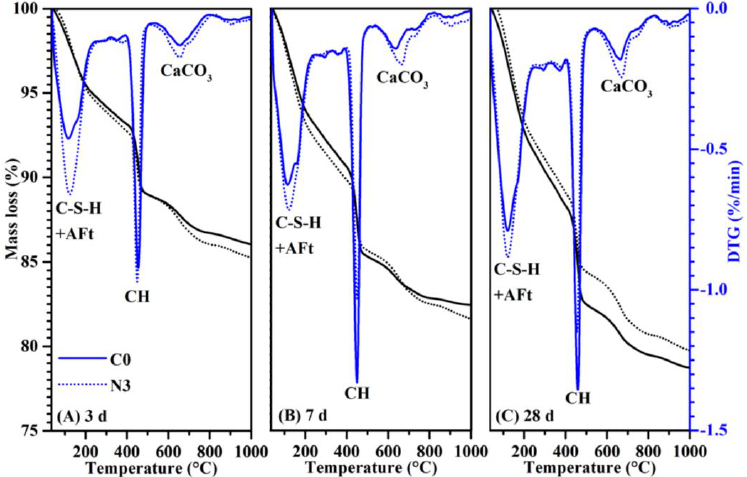
Figure 16. TG-DTG curves of different cement pastes at ( A ) 3 days, ( B ) 7 days and ( C ) 28 days.